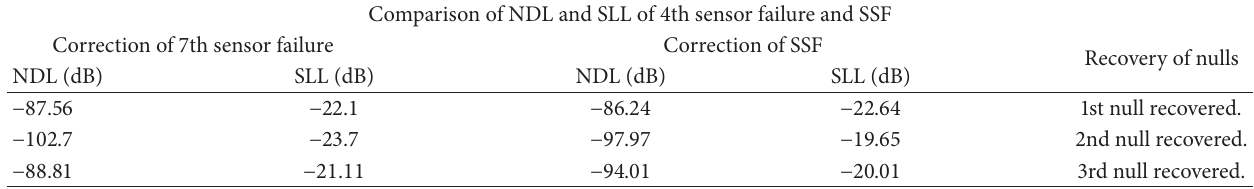
Table 7: Recovery of three nulls.